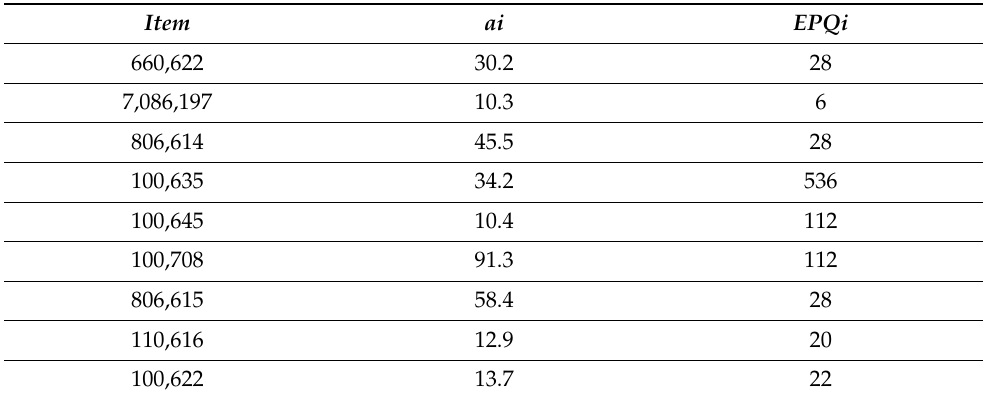
and 𝐸𝑃𝑄 values. 𝑖 𝑖